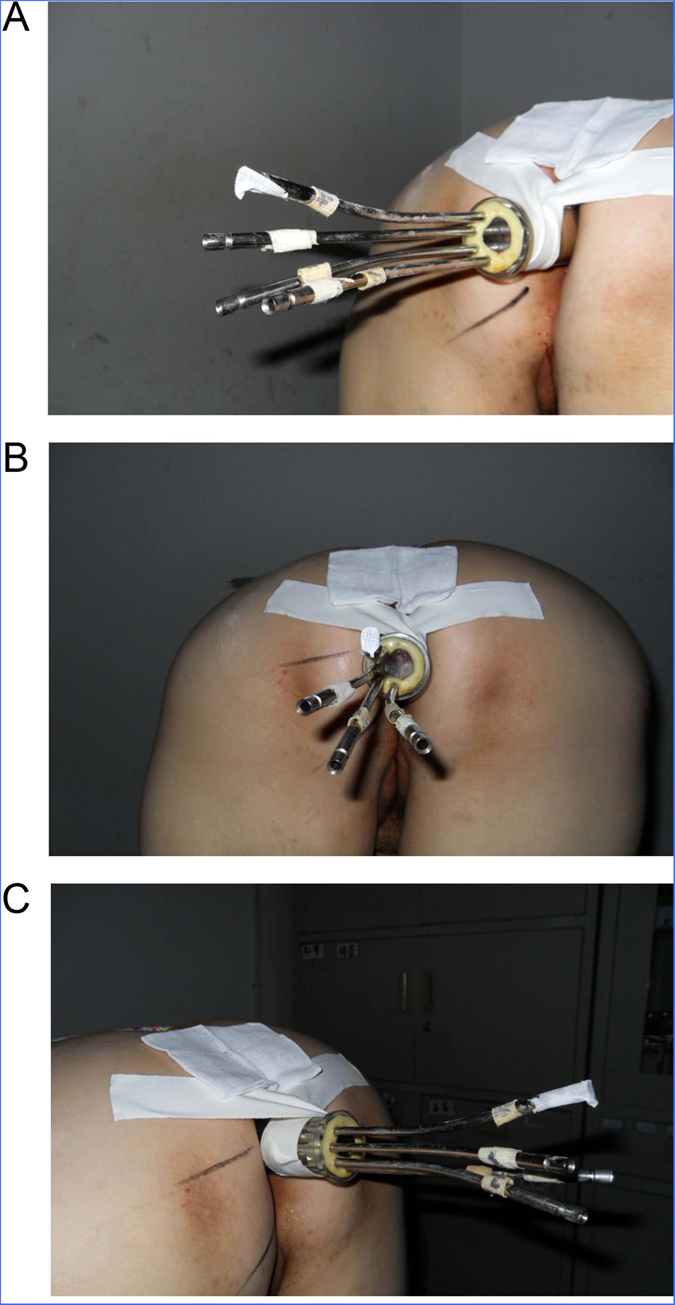
Three or four channels of the off-axis applicator (diameter 3.5 cm) selected based on the dimension of the tumor were inserted to the top of rectum with the patient in the knee-to-chest position.The numbers of dwell points were given according to the length of the tumor and the distance from the anal canal entrance (1 cm beyond the margin of the tumor).